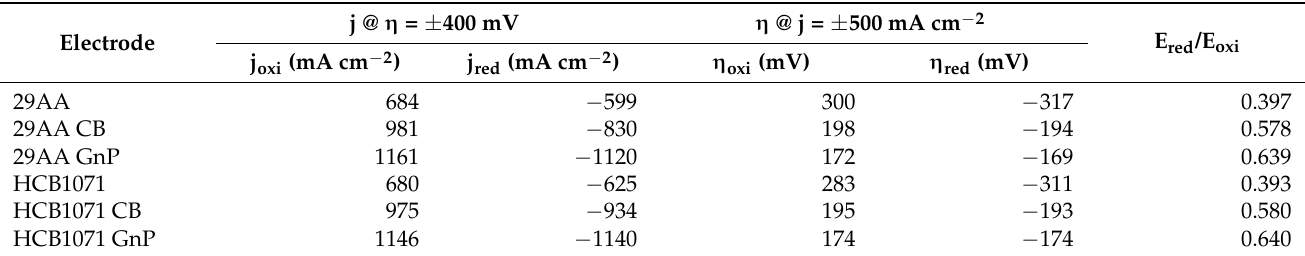
Table 2. Results of polarisation and oxidation/reduction cycling tests of bromine electrodes. Data taken from Figure 6.